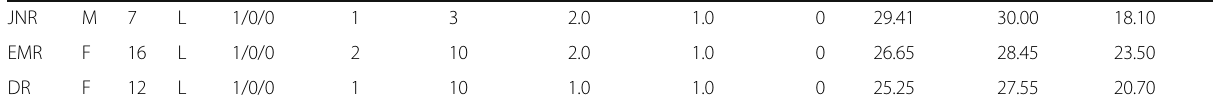
a If more than one area was affected, an index area was selected for thermographic evaluation (index area underlined) b (1) toe nail rim = 1, (2) toe nail rim = 2, (3) toe nail rim = 3, (4) toe nail rim = 4, (5) toe nail rim = 5, (1) toe sole = 6, (2) toe sole = 7, (3) toe sole = 8, (4) toe sole = 9, (5) toe sole = 10, foot sole = 11, heel = 12, medial foot rim = 13, lateral foot rim = 15 c Taking into consideration the index lesion (presence of oedema, erythema or warmness = 1 point, ulcer = 1 point, fissure = 1 point, pustule/abscess = 1 point,